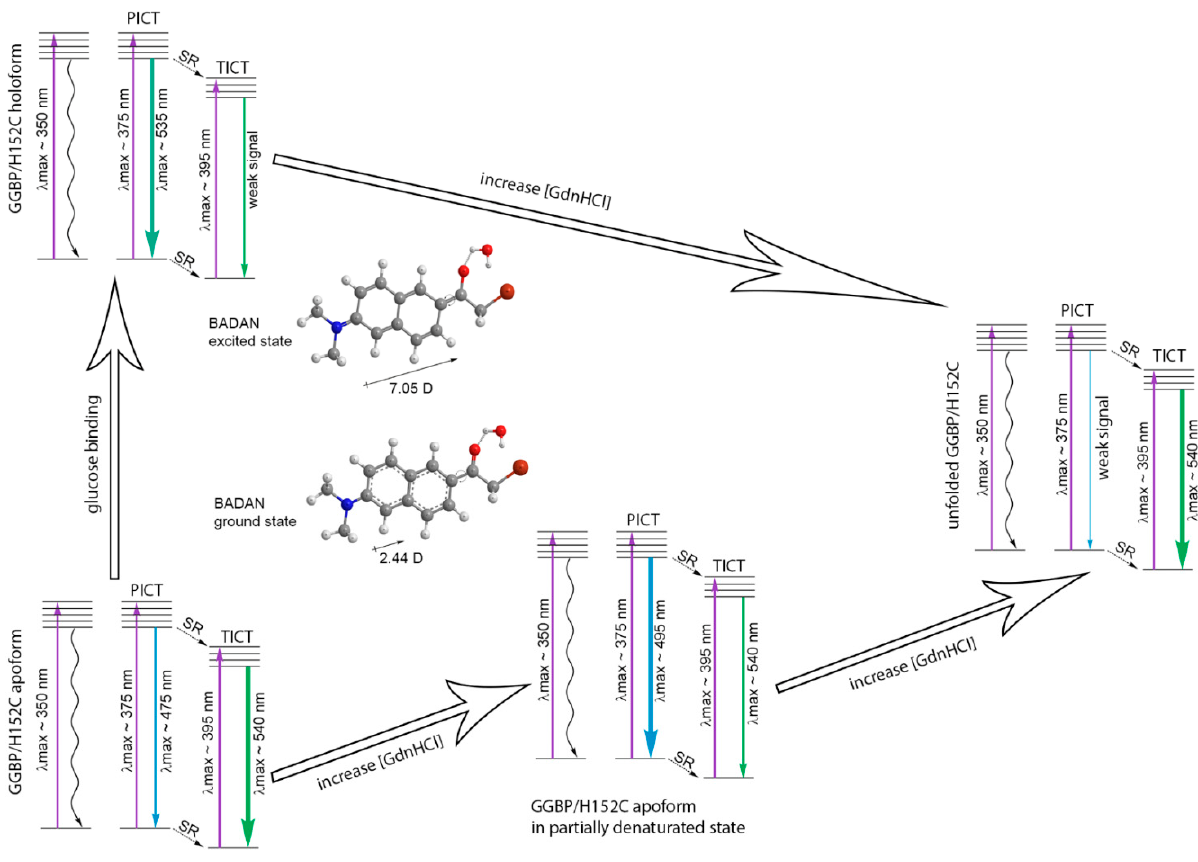
Figure 9. Diagram illustrating BADAN photoprocesses during conformational changes in GGBP/H152C during the interaction of this protein with glucose and the unfolding of the GGBP/H152C apo and holoform induced by GdnHCl. The energy levels of the dye are indicated by horizontal lines, vertical purple arrows illustrate the transition of BADAN molecules from the ground to an excited state, blue and green arrows illustrate the radiative transitions of BADAN from PICT (planar intramolecular charge transfer state) and TICT (twisted intramolecular charge transfer state) to the ground state, and wavy arrows indicate nonradiative BADAN transitions. The relaxation of the excited and ground state of the dye under the action of the solvent is indicated by the abbreviation SR and is represented by dashed arrows.